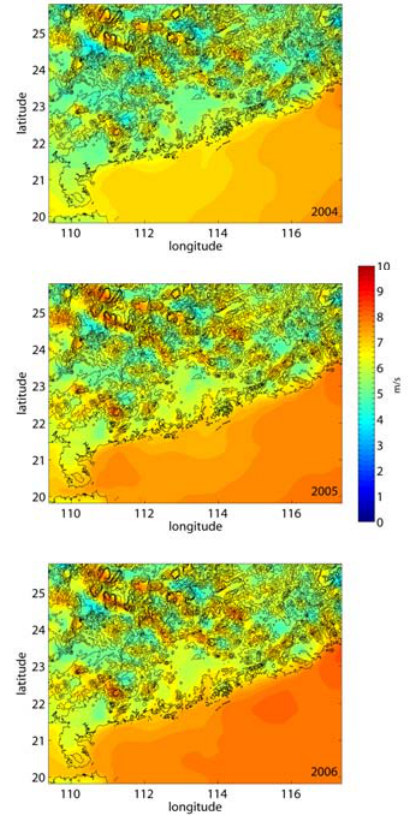
Figure 7. Annual mean wind speed at 60 m above ground over GD in (a) 2004, (b) 2005 and (c)